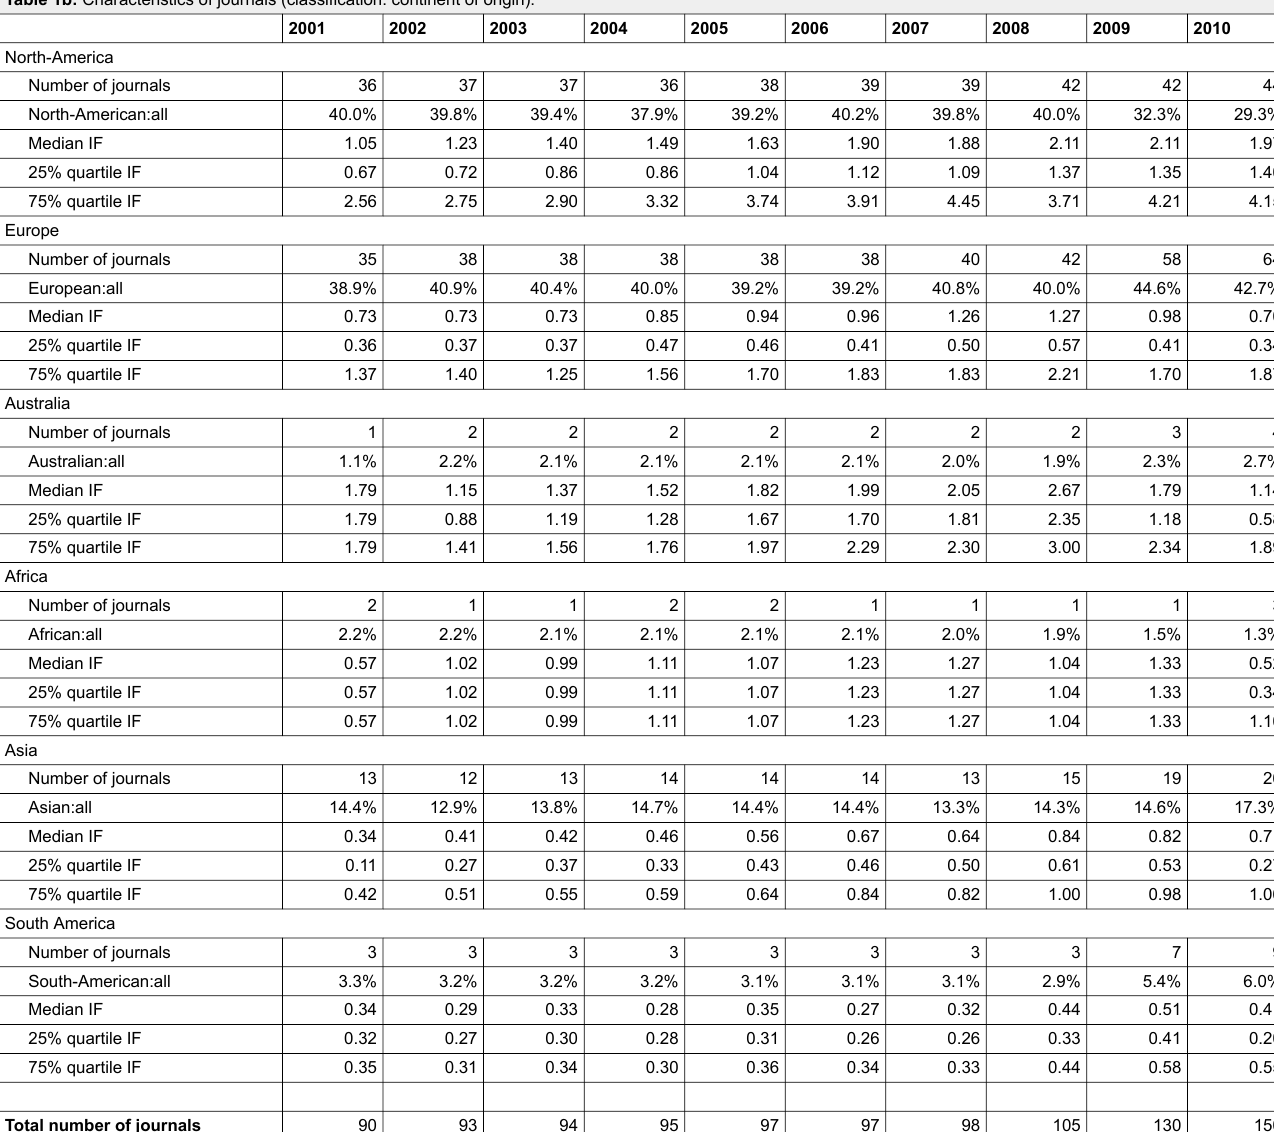
Table 1b: Characteristics of journals (classification: continent of